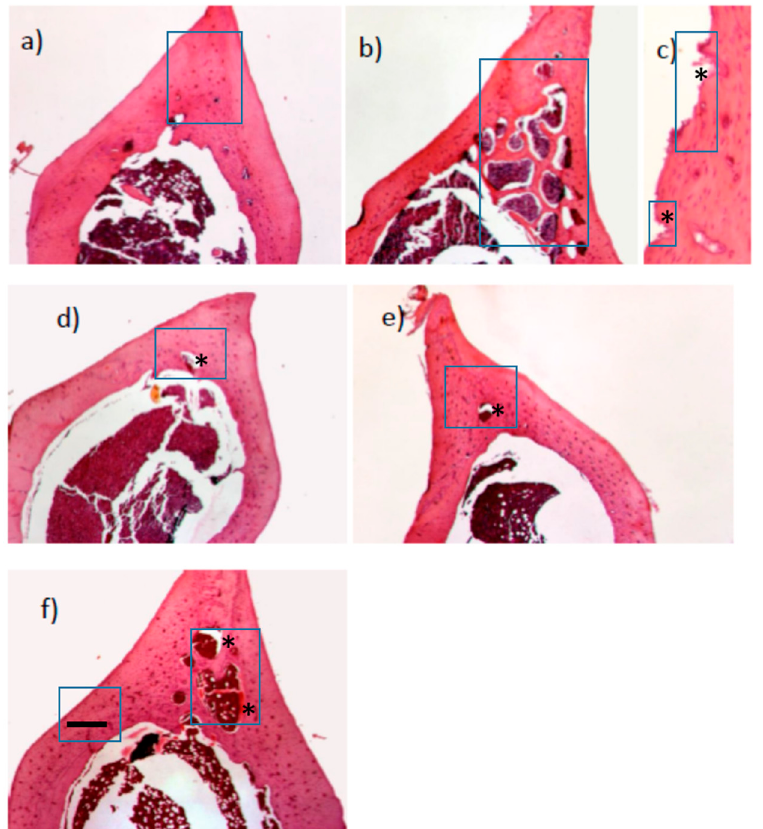
Figure 2. Histological examination of rats’ bone stained section with HE. ( a ) Control group showed normal architecture of the bone tissue (shown in box); ( b ) Retinoic acid-treated group (osteoporotic model) showed formation of multiple large intracortical cavities (shown in box) and thinning of the cortex and eroded endosteal bone surface (shown in box with *) ( c ); Proanthocyanidins ( d ) or icariin ( e ) showed complete recovery with essential features of the normal bone and complete formation of trabeculae and thickness with one or two small intracortical cavities (shown in box with *); ( f ) alendronate showed signs of improvemaent of femoral structure and the increased thickness (shown in box with — ), size of the intracortical cavities are significantly reduced, while the inner surface of the cortex still shows irregularities in certain places (shown in box with *).